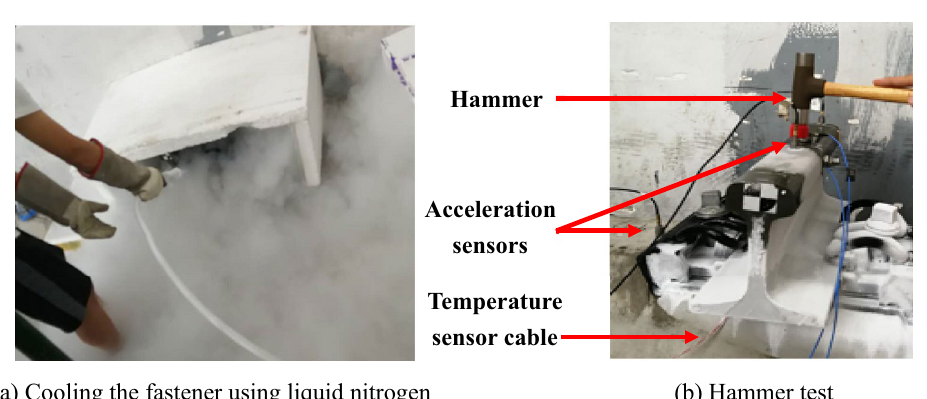
Figure 13. Measurement of fastener stiffness and damping at freezing temperatures. ( a ) Cooling the fastener using liquid nitrogen, ( b ) Hammer